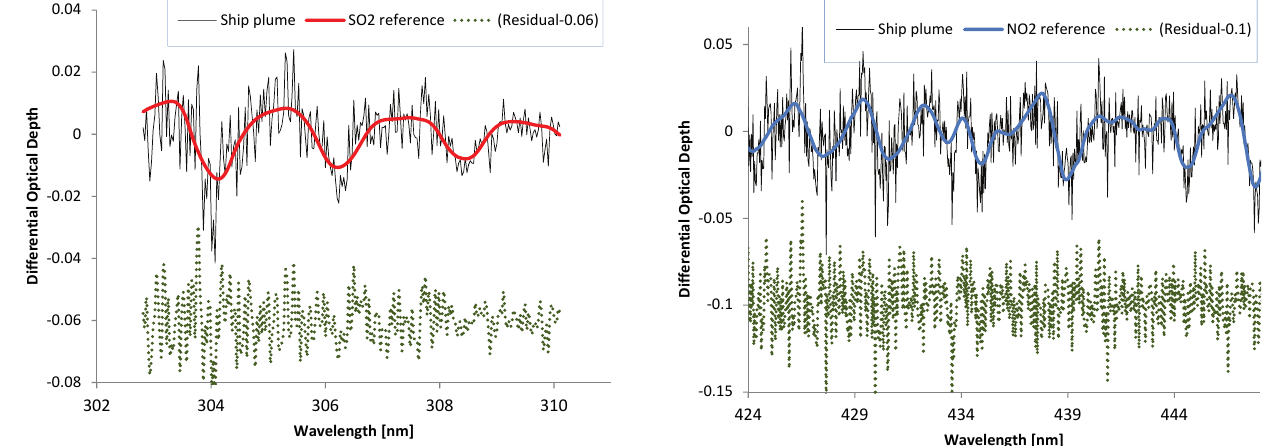
Fig. 2. A ship plume measurement of NO 2 corresponding to the last plume in Fig. 6. The differential optical depth is shown when normalizing spectra inside and outside the ship plume, respectively, and correcting for the ring spectrum. In addition a fitted reference spectrum of NO 2 is shown. The lower part shows the residual after the fitting